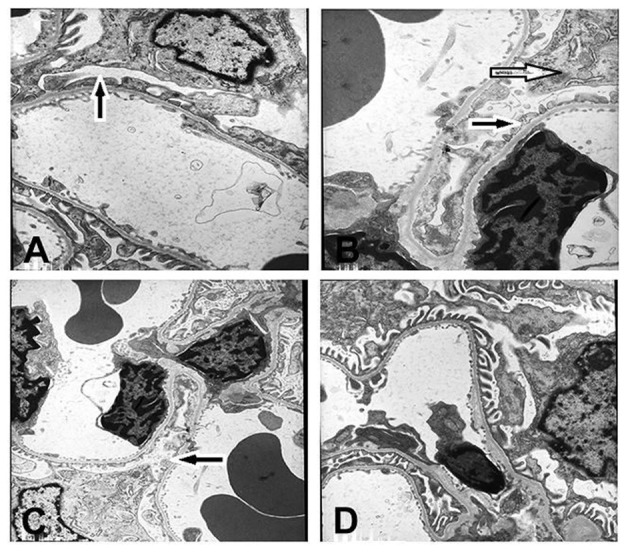
Ultrastructure of renal tissue (× 6000). Podocytes had undergone foot process fusion to different extents (A–C). There was some mesangial cell and mesangial matrix proliferation in B. No electron-dense deposits were observed in (D). (A) The 6 × 104 PFU RSV + vehicle, day 14 subgroup (Group A3); (B) The 6 × 104 PFU RSV + 6 × 106 PFU RSV, day 14 subgroup (Group B3); (C) The 6 × 104 PFU RSV + 6 × 104 PFU RSV day 14 subgroup (Group C3); (D) Vehicle + vehicle group, day 14 subgroup (Group D3). Black arrow () represents the foot profusion of podocytes, and the white arrow () shows the mesangial matrix proliferation.